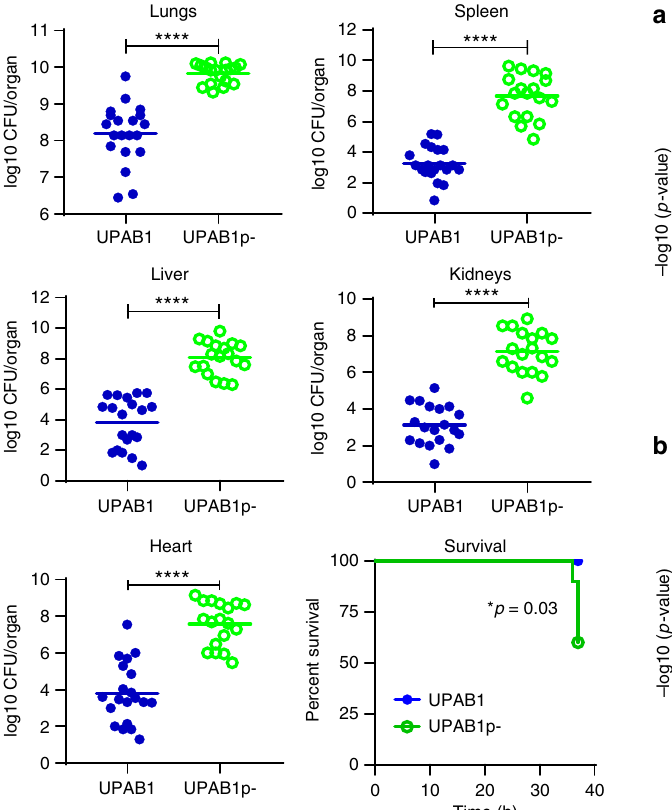
Fig. 5 pAB5 is detrimental in an acute pneumonia murine model. Mice were intranasally inoculated with 1 × 10 9 CFU of either the WT UPAB1 or UPAB1p- strain. Following 36 h of infection, total numbers of CFU recovered were determined for lungs, spleen, liver, kidneys and heart. Each symbol represents an individual mouse. Data shown are pooled from two independent experiments. For each strain, the mean value is shown as the horizontal line. Statistical analyses were performed using the